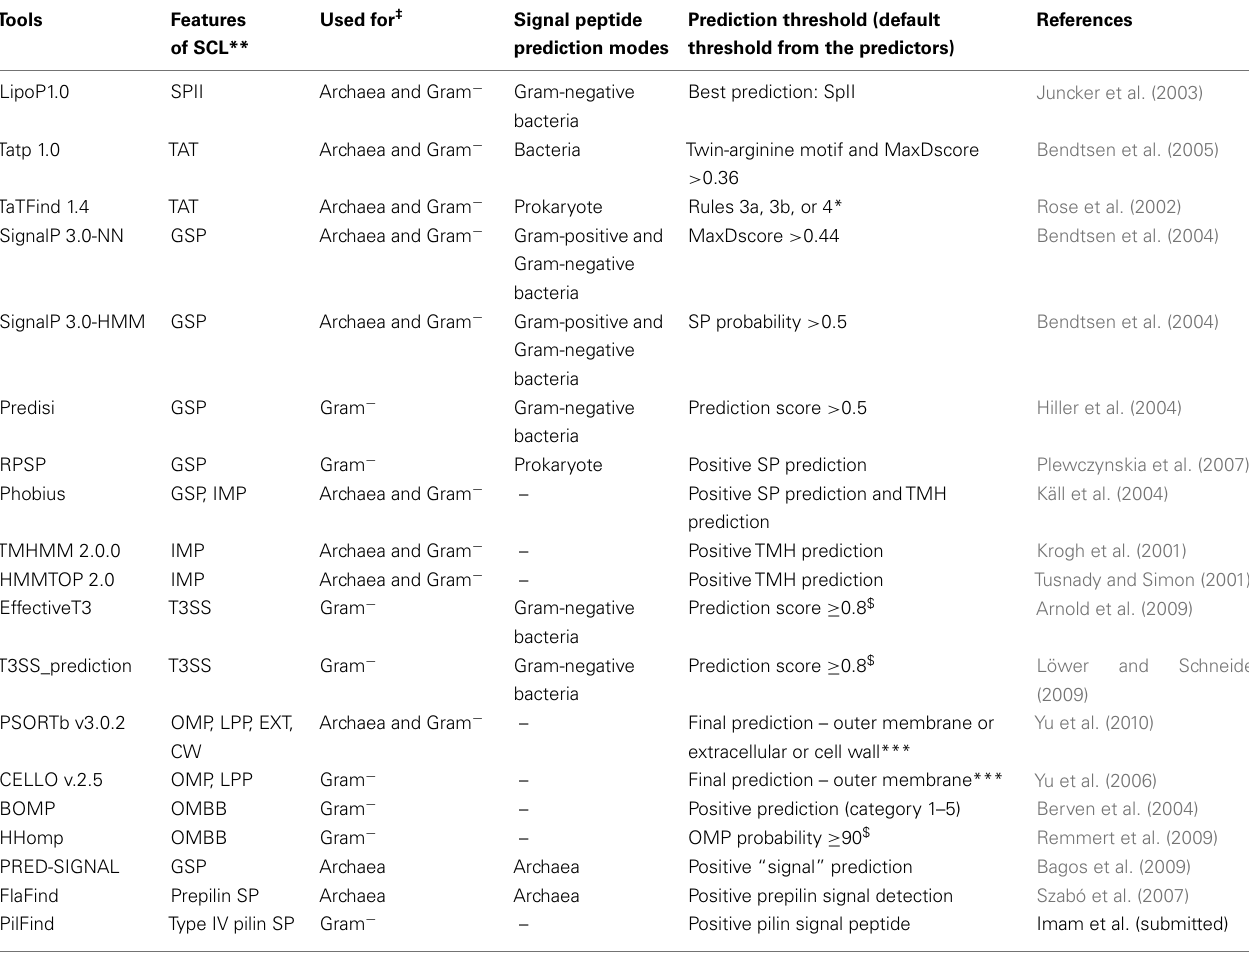
Table 1 | List of SCL and feature specific tools used in the prediction